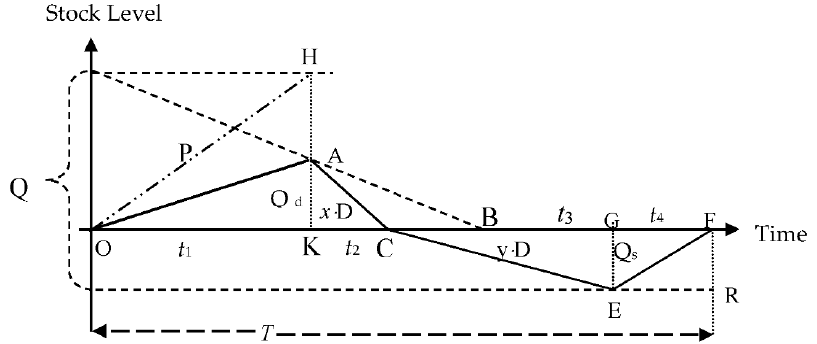
Figure 1. On-hand stock flow for x > 1 and y < x .